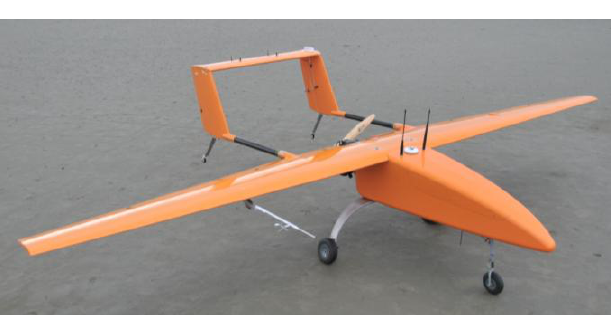
Figure 1. The SP-80